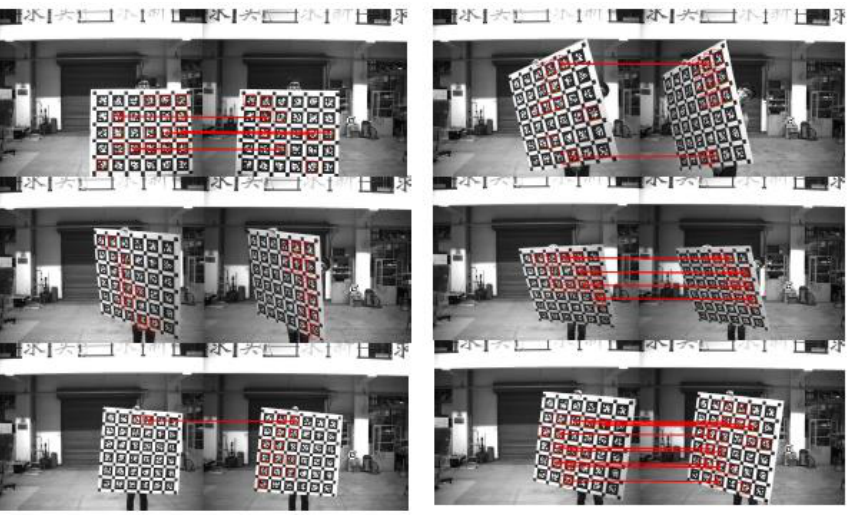
Figure 26. Extracted matching points and pose (7 – 12).